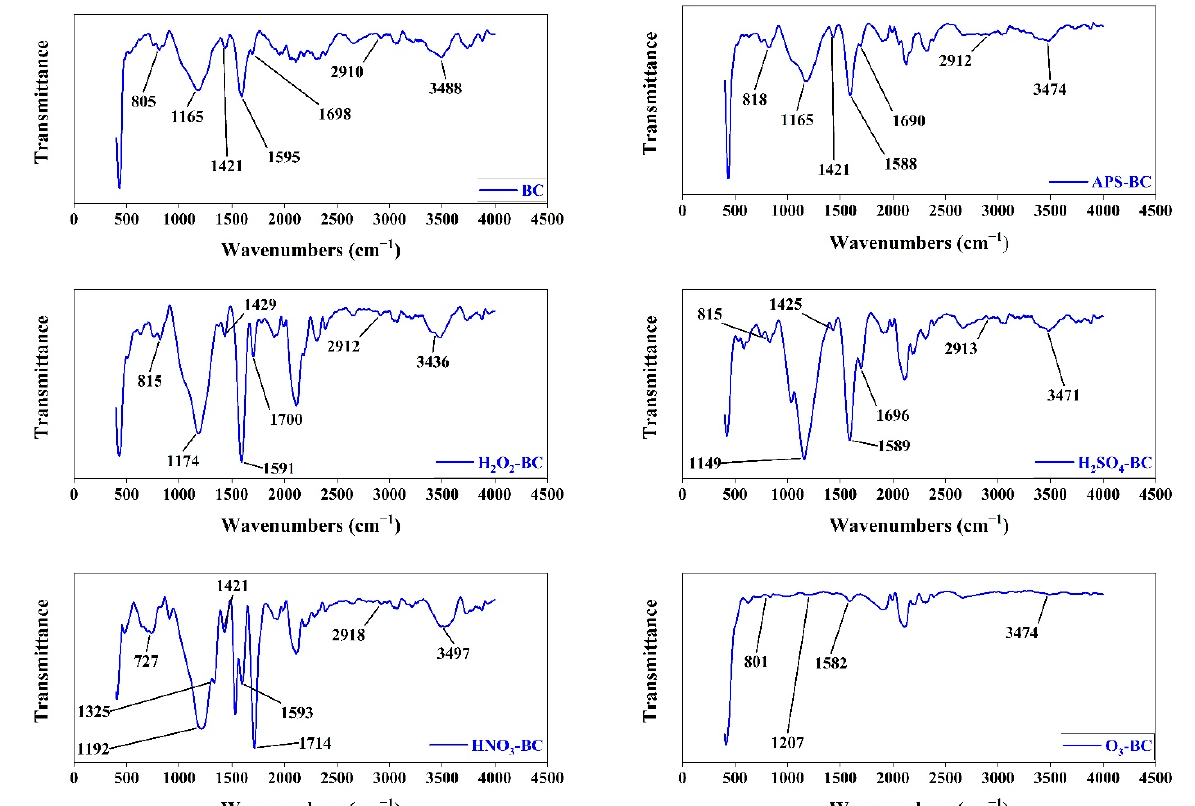
Figure 2. IR Spectra of BC, APS-BC, H 2 O 2 -BC, H 2 SO 4 -BC, HNO 3 -BC, O 3 -BC.